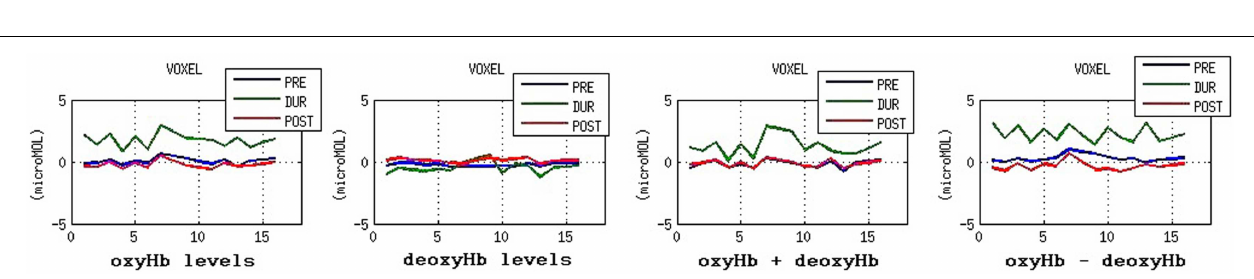
FIGURE 3 | Frontal hemodynamic responses in schizophrenia patients before (pre), during, and after (post) KB through all the 16 voxels . Abbreviations: oxyHb, oxygenated hemoglobin; deoxyHb, deoxygenated hemoglobin; totalHb, total hemoglobin; KB, kapalabhati.